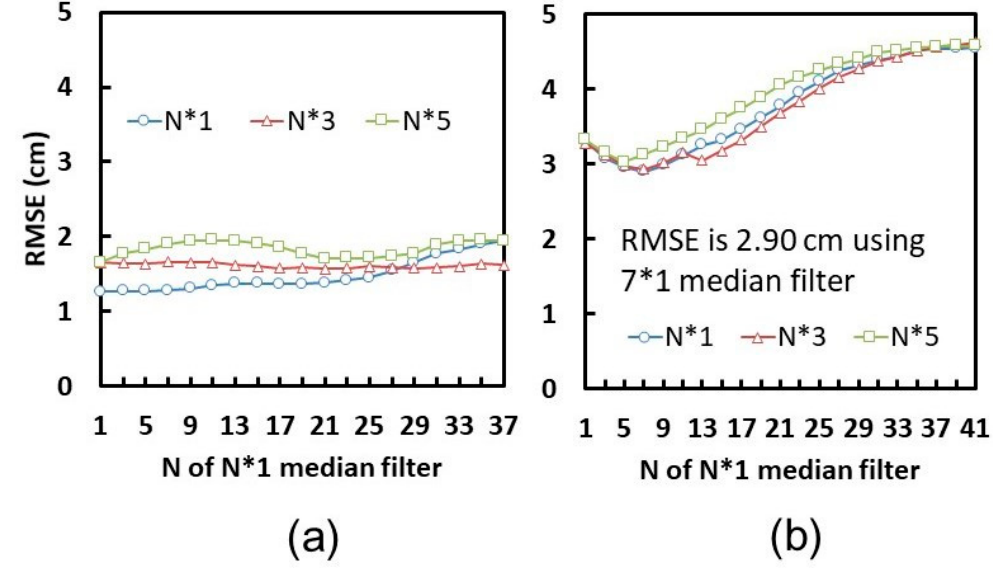
Figure 6. RMSE of height from 3D models computed by the different sizes of median filters derived from data on 14 DAP. ( a ) Ridge; ( b ) plant.